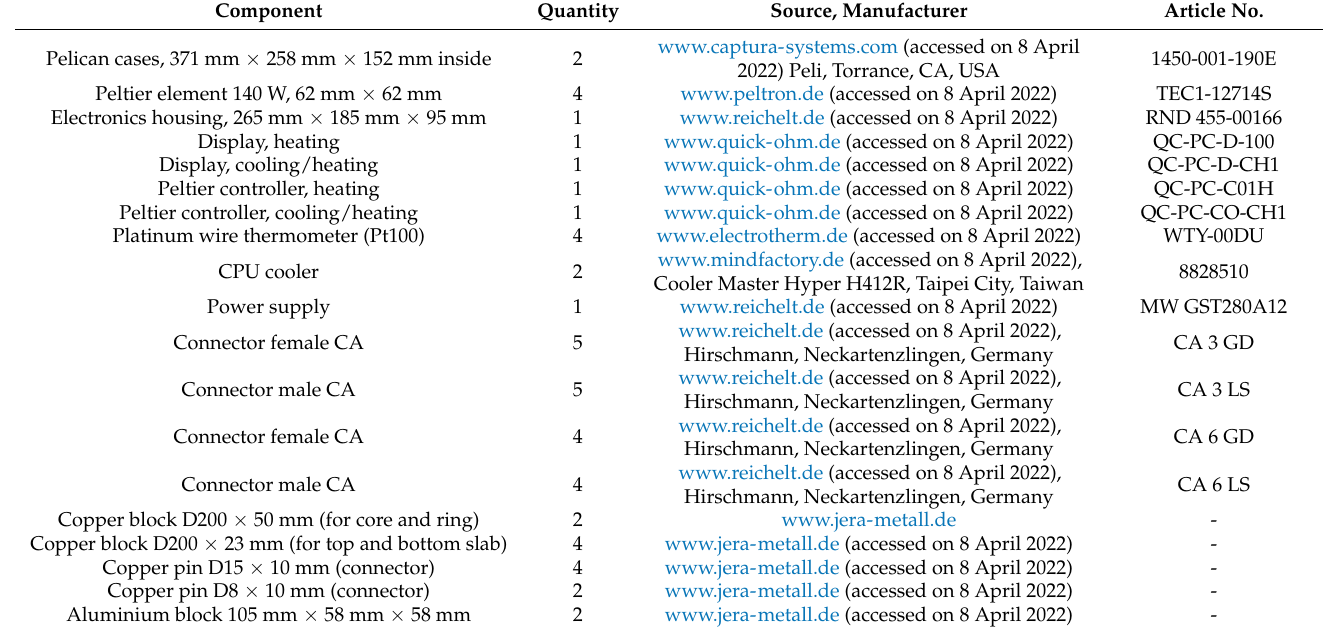
Table A1. List of components used to construct one pair of SoPhaBs (e.g., cold, warm), which is the typical use-case for most FODS applications. The sources and manufacturers are given for orientation purposes only and do not constitute any endorsement.